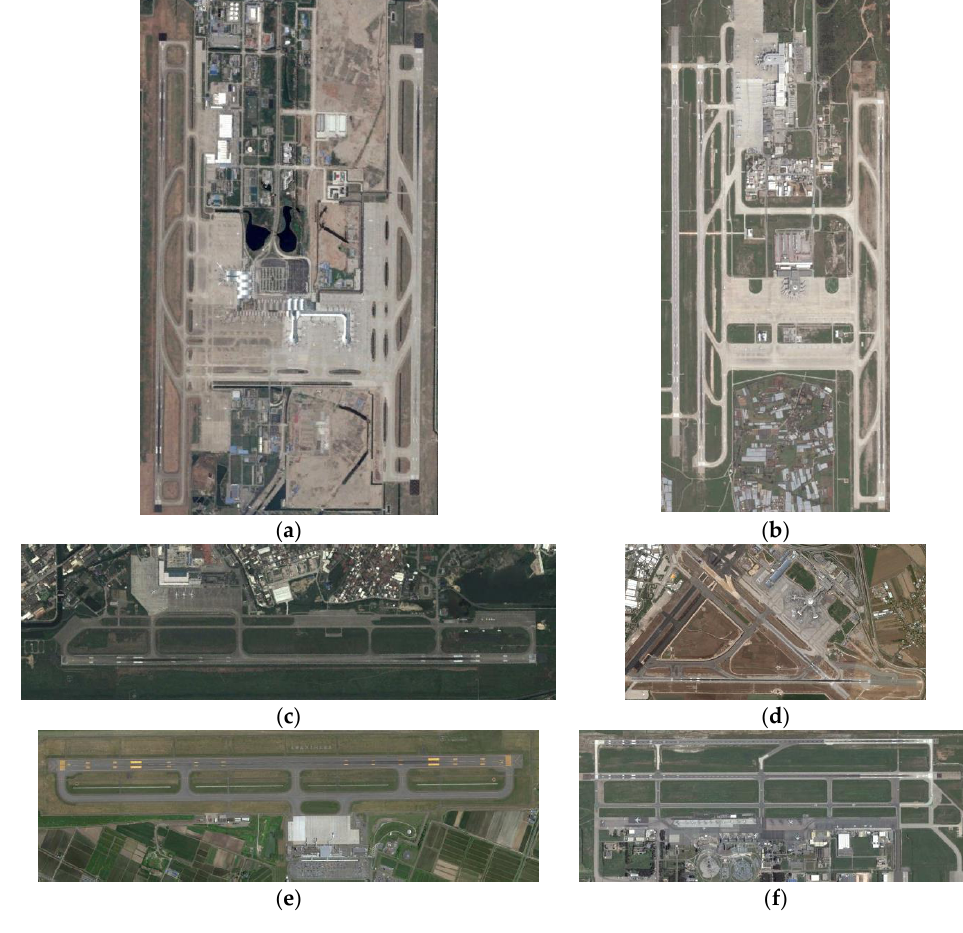
Figure 7. Examples of airports.